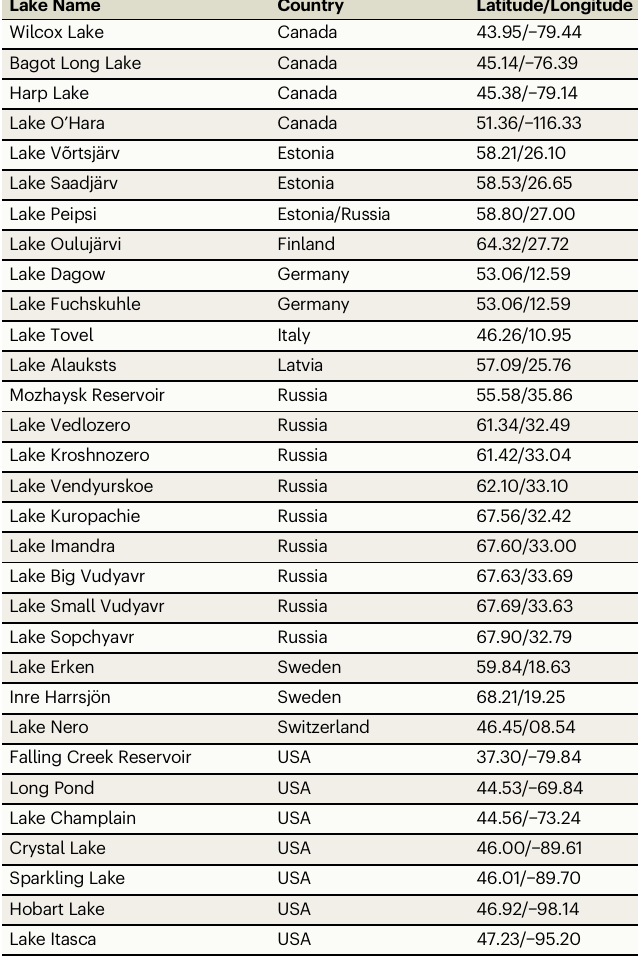
Fig.1|SamplinglocationsofseasonallyfrozenlakesandNorthernHemisphere winter air temperatures since 1880. a Open access map from the International Permafrost Association (https://www.eea.europa.eu/legal/copyright) showing Ice- Blitz sampling locations with lake names during winter 2020/2021 (red dots). Also